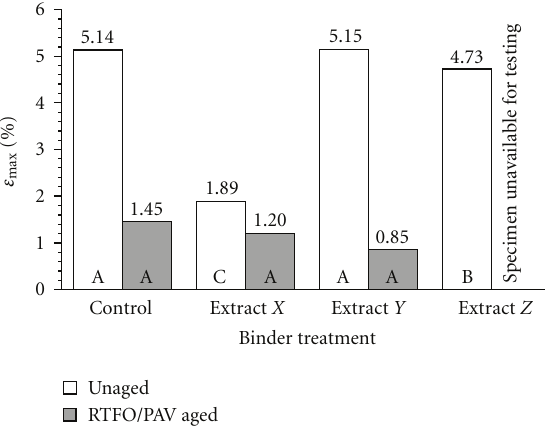
Figure 15: Maximum tensile strain at failure of original and PAV aged control binder and binder with finish extracts tested at − 12 ◦ C. Statistical comparisons were made within each stage of aging.